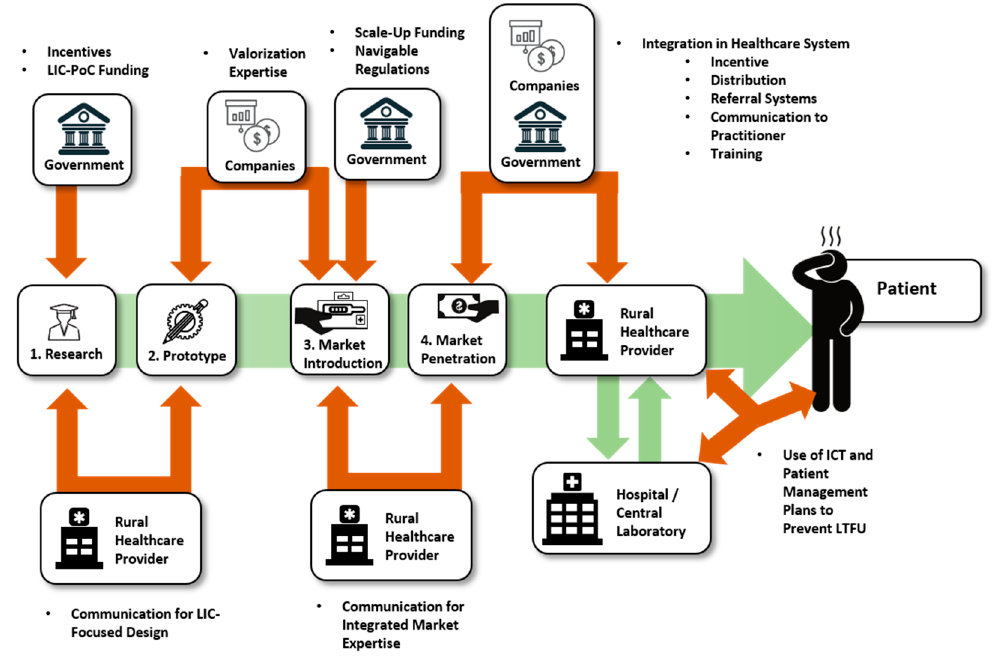
Figure 5. Identified Pivotal Points and Influencing Forces.